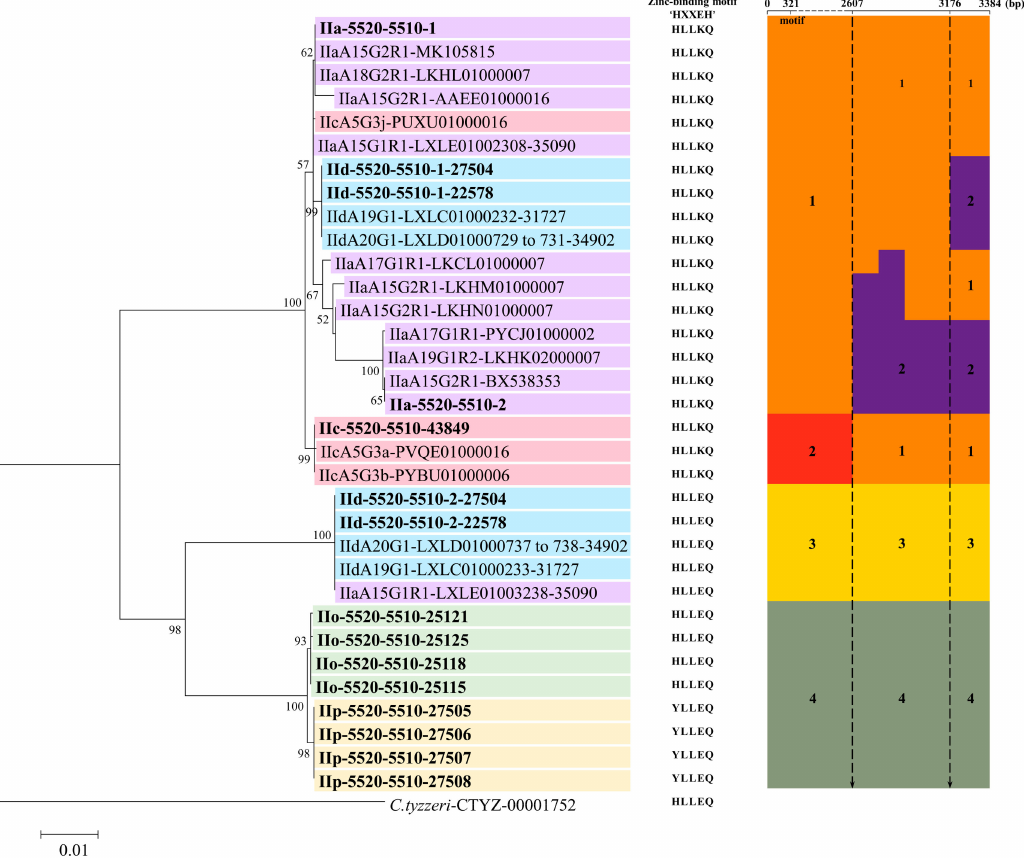
Figure 4. The phylogenetic relationship among 34 cgd6_5520-5510 gene sequences. There is a discordance in subtyping between cgd6_5520-5510 and gp60 genes. The phylogenetic analysis